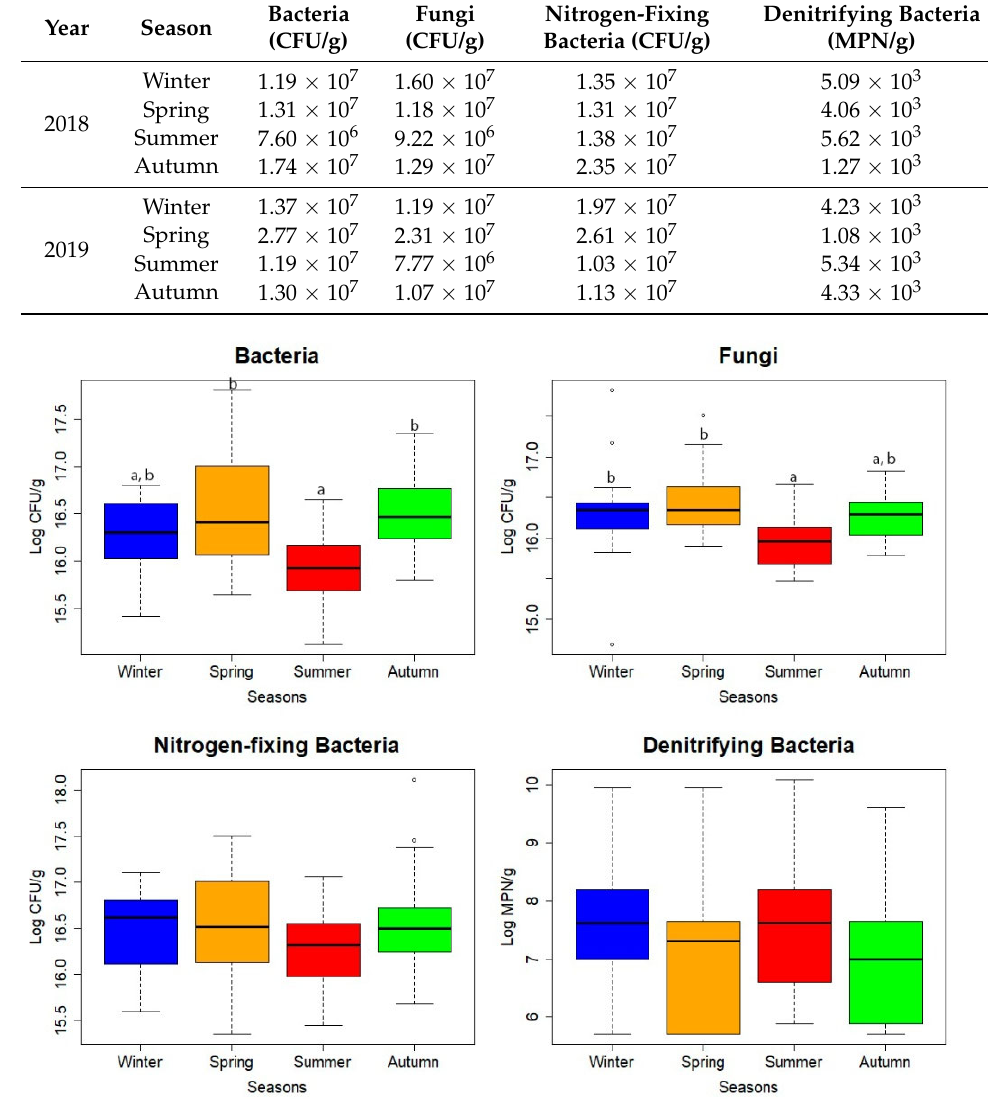
Figure 6. Variation in total bacteria and fungi and nitrogen-fixing and denitrifying bacteria abundance according to seasons. Boxes with different letters indicate a significant difference among them ( p ≤ 0.05). The letter a corresponds to the lowest